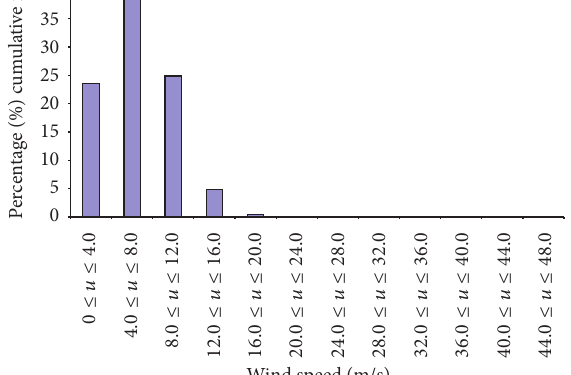
The maximum and minimum values of the standard devi- ation were observed during autumn (3.15) and spring (2.64). factor ( 𝑘 ) ranged between 2.08 during summer and